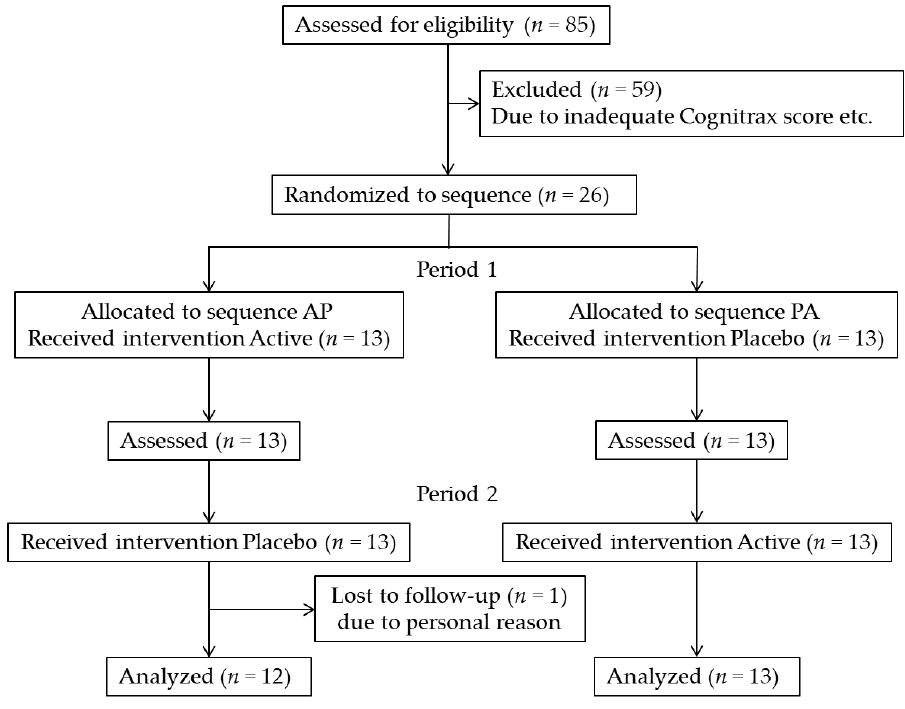
Figure 1. Flow diagram of the trial.